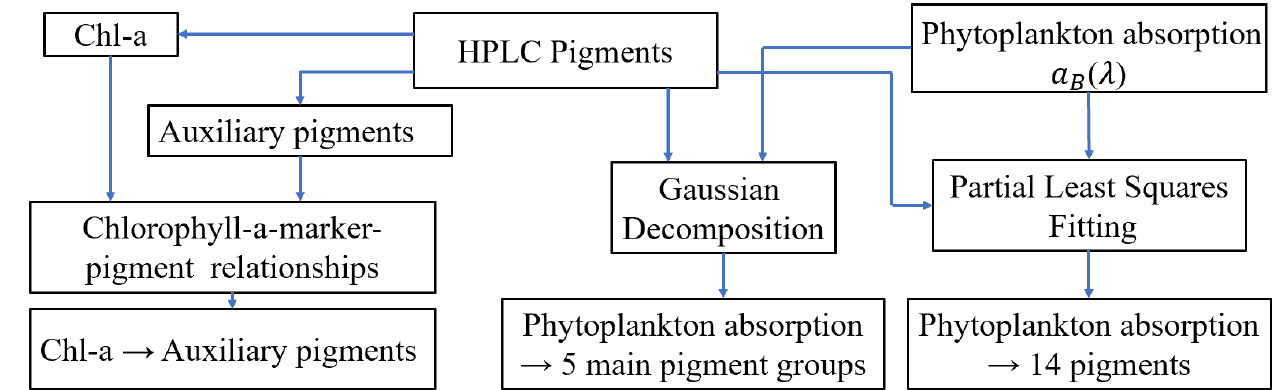
Figure 2. Schematic overview of the data and processing steps used to estimate pigments from phytoplankton absorption and total chlorophyll-a (Chl-a) concentration.